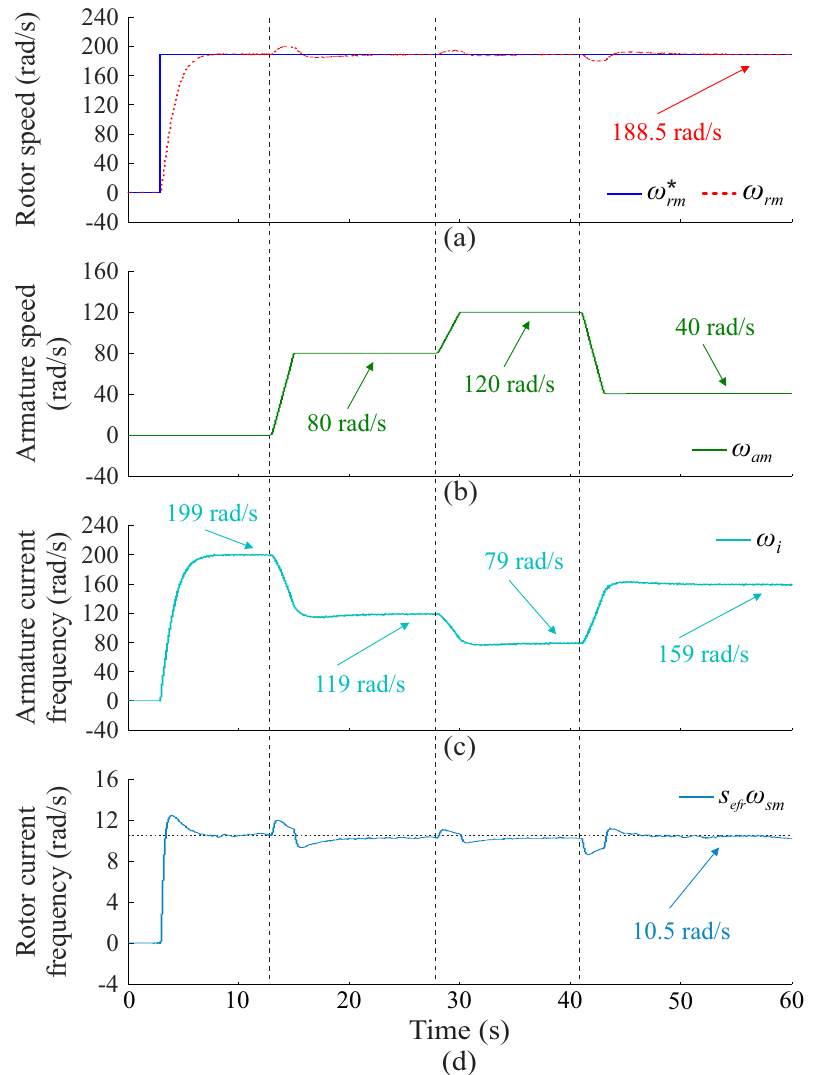
Figure 16. Relationship between mechanical speed and angular frequency in the EFR device: ( a ) EFR rotor speed, ( b ) EFR armature speed, ( c ) armature current frequency and ( d ) Rotor current